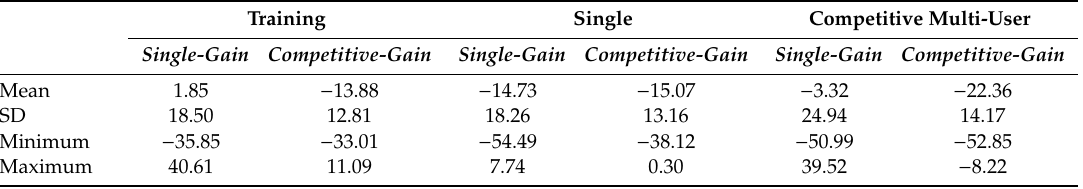
Table 1. Descriptive statistics of relative ERD (%) for the conditions training, single, and competitive multi-user for the groups single-gain and group competitive gain. Training Single Competitive Multi-User Single-Gain Competitive-Gain Single-Gain